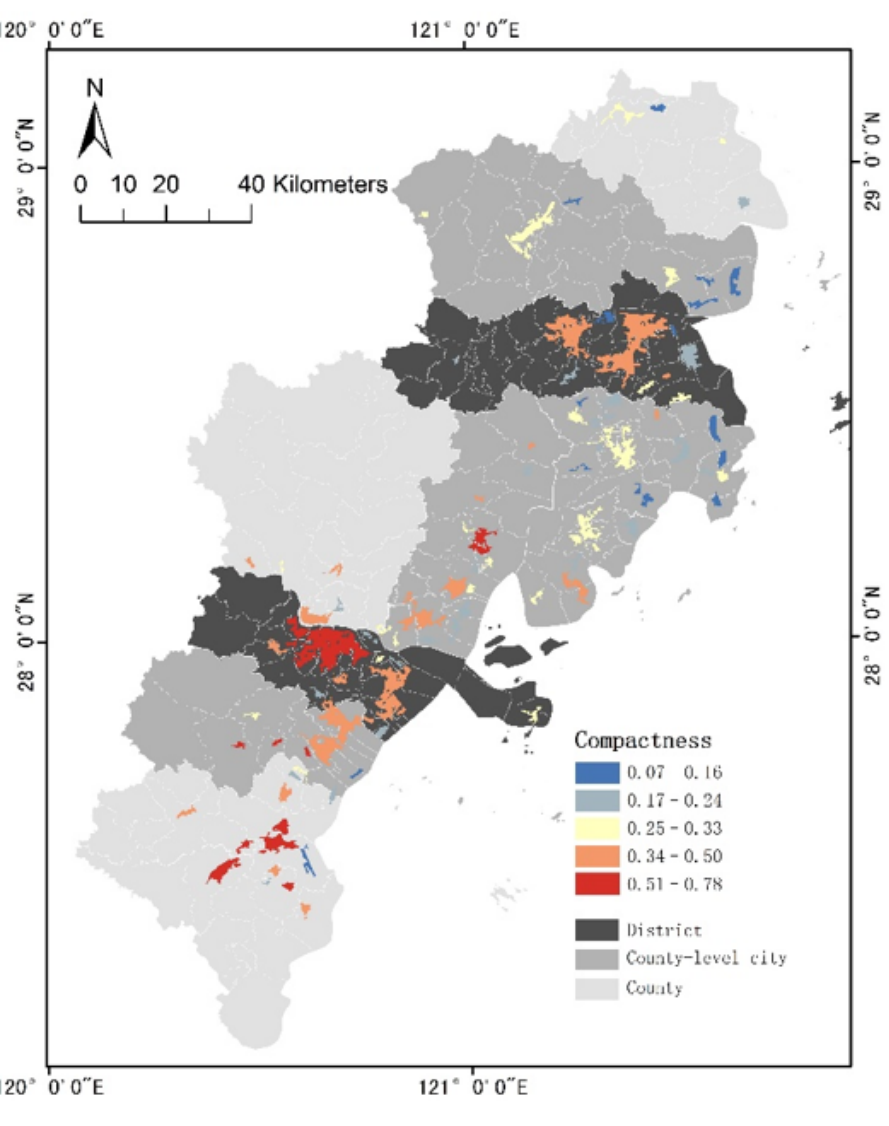
Figure 11. Spatial distribution of PUAs compactness.